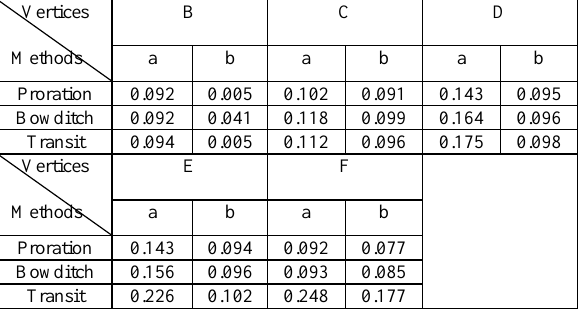
Table 1. The length of the larger diameter (b) and the smaller diameter (a) of the error ellipses in meters obtained from the analysis of the regular hexagonal results with an observation error of 10 centimeters for the lengths and 20 seconds for the